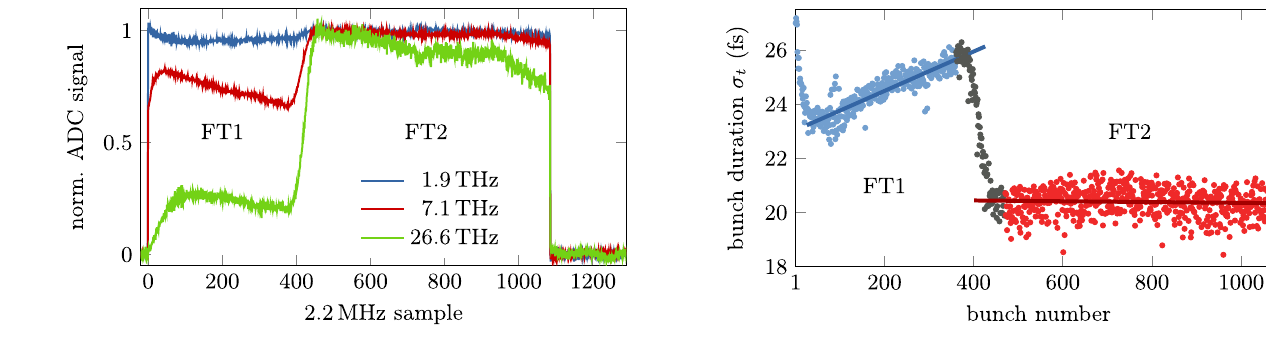
FIG. 12. Rms bunch duration along the bunch train during user operation with two rf flat-tops (FT1 and FT2). Bunches in FT2 (red) are stronger compressed than bunches in FT1 (blue). FT1 exhibits an increasing slope on the rms bunch duration fitted by the solid line.